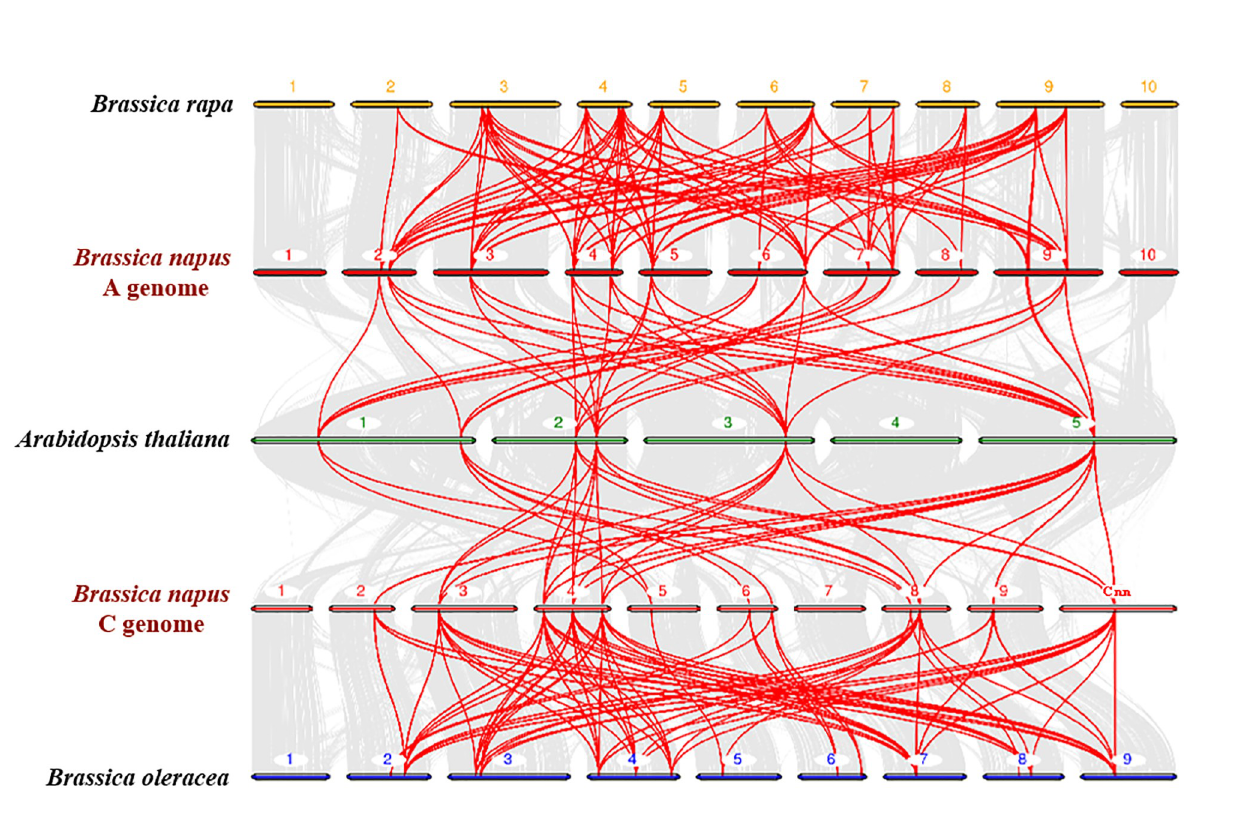
Fig 3. Synteny analysis of PHT1 genes in Brassica napus , B . rapa , B . oleracea and Arabidopsis thaliana chromosomes. Gray lines in the background indicate the collinear blocks within B . napus and other plant genomes, while the red lines highlight the syntenic PHT1 gene pairs. Genes located on B . napus A genome are syntenic with genes of B . rapa and A . thaliana , while genes located on B . napus C genome are syntenic with genes of B . oleracea and A . thaliana .